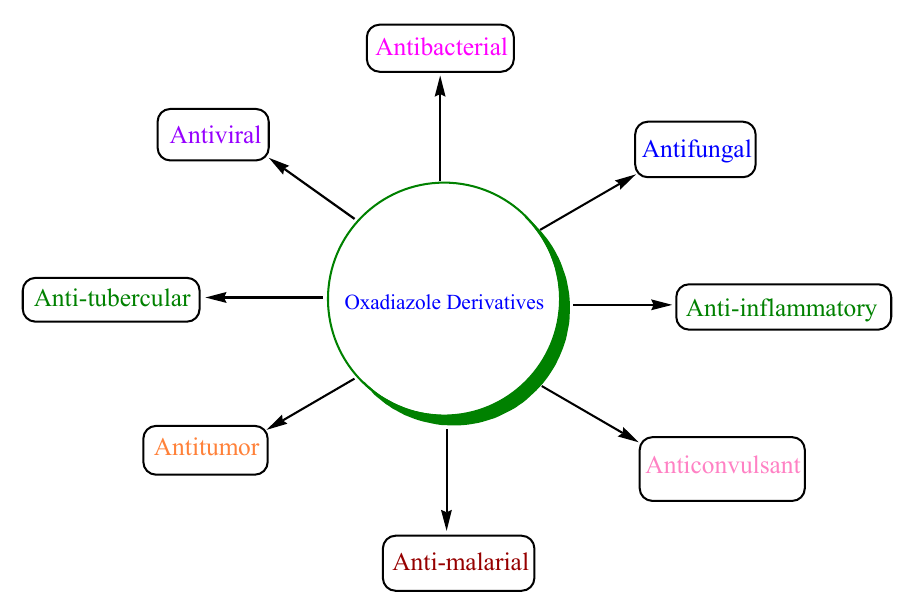
Figure 6. Biological activities of oxadiazole derivatives.